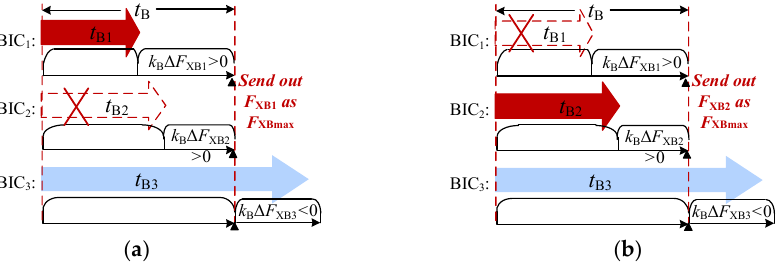
Figure 10. Influence of the BIC outage on the 2nd DL selection among BICs under ( a ) the non-leader BIC outage, ( b ) the leader BIC outage.